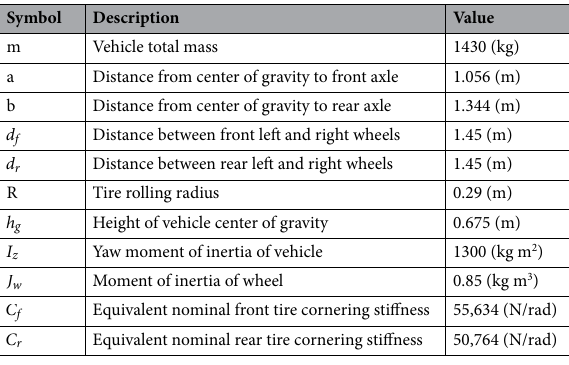
Table 1. Main DDAV parameters.